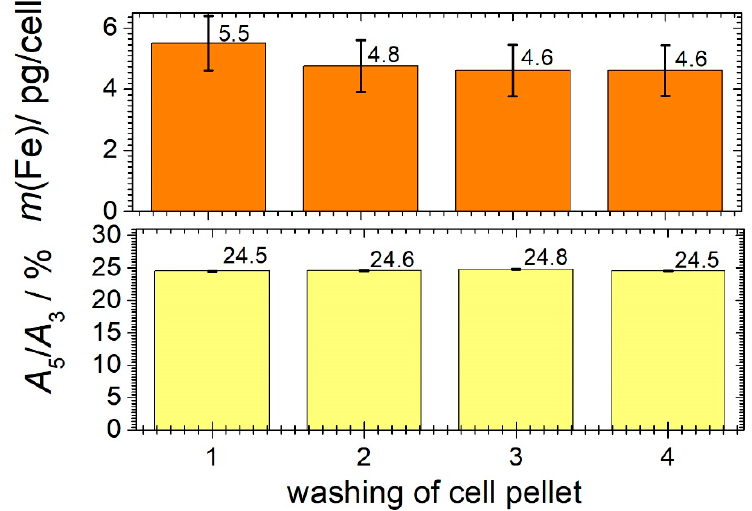
Figure 6. The iron mass determined by MPS at B = 12 mT for repeated washing of 10 6 THP-1 monocytes loaded with Syn-COOH ( c (Fe) = 0.5 mmol/L) after an incubation time of 10 min. Uncertainty was determined by repeating the wash series eight times. The numbers on each bar denote the corresponding values of m (Fe) and A 5 / A 3 .